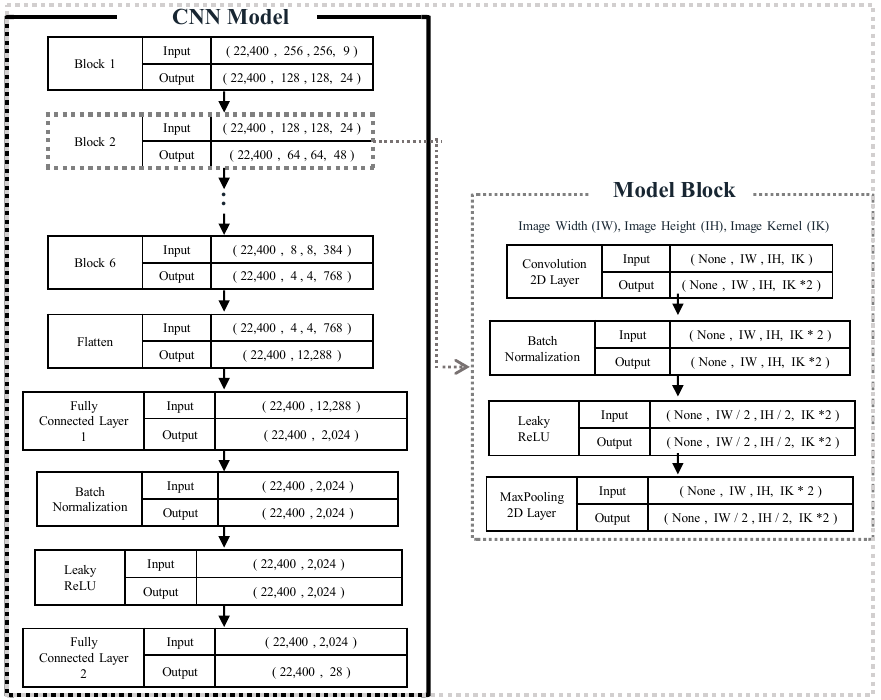
Figure 6. Architecture of the convolutional neural network for the delamination assessment in smart composite laminates.